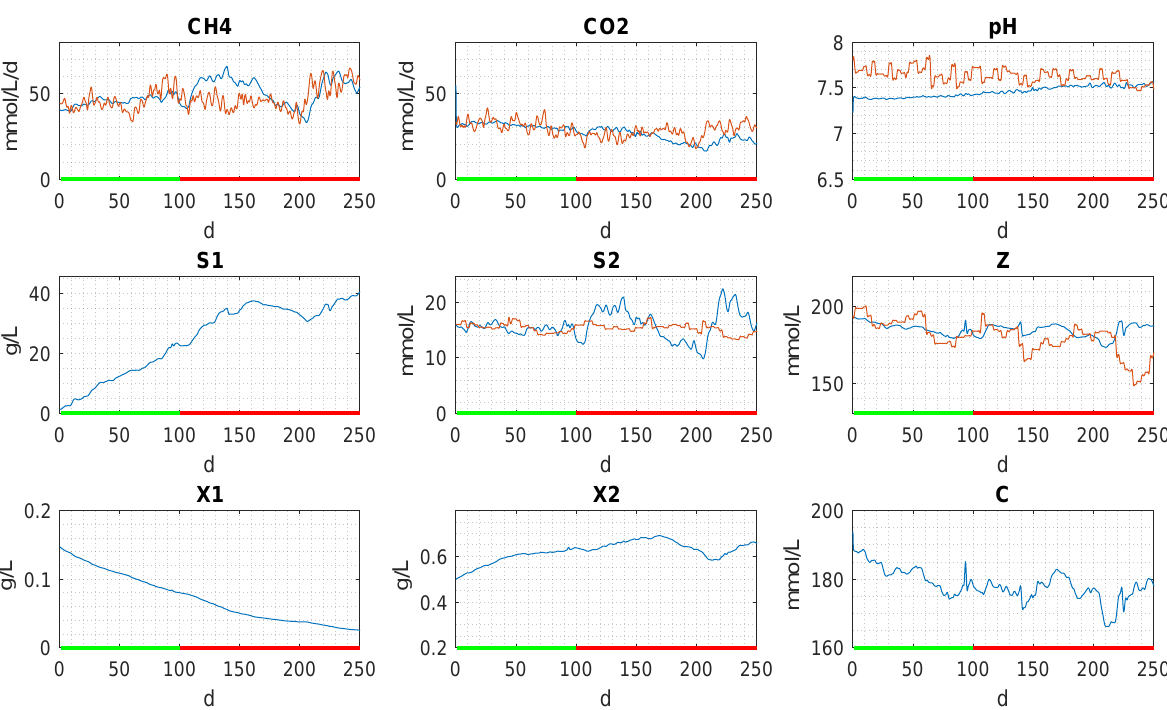
Figure 6: The results of the model adaptation based on the experimental data collected from the VEAS. The red curve is the experimental data and the blue curve is the AM2 model based on the estimated model parameters. In time axis, the green band shows the identification period and the red band shows the validation period.